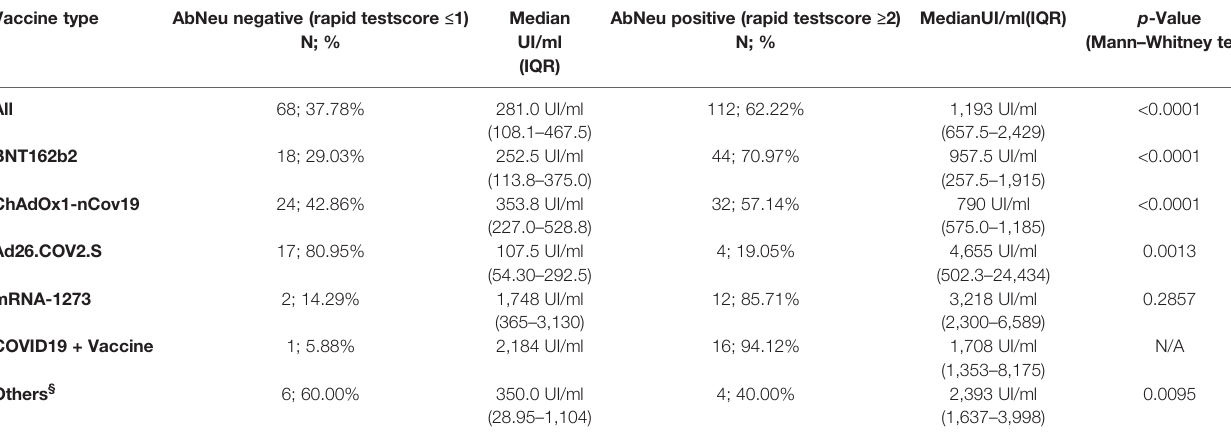
TABLE 5 | Anti-RBD antibody titer distribution in AbNeu-positive and AbNeu-negative individuals who received different vaccines. Vaccine